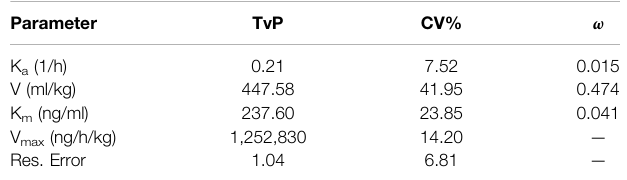
TABLE 3 | Population PK results of oral administration of HY-021068 to beagle dogs. Parameter